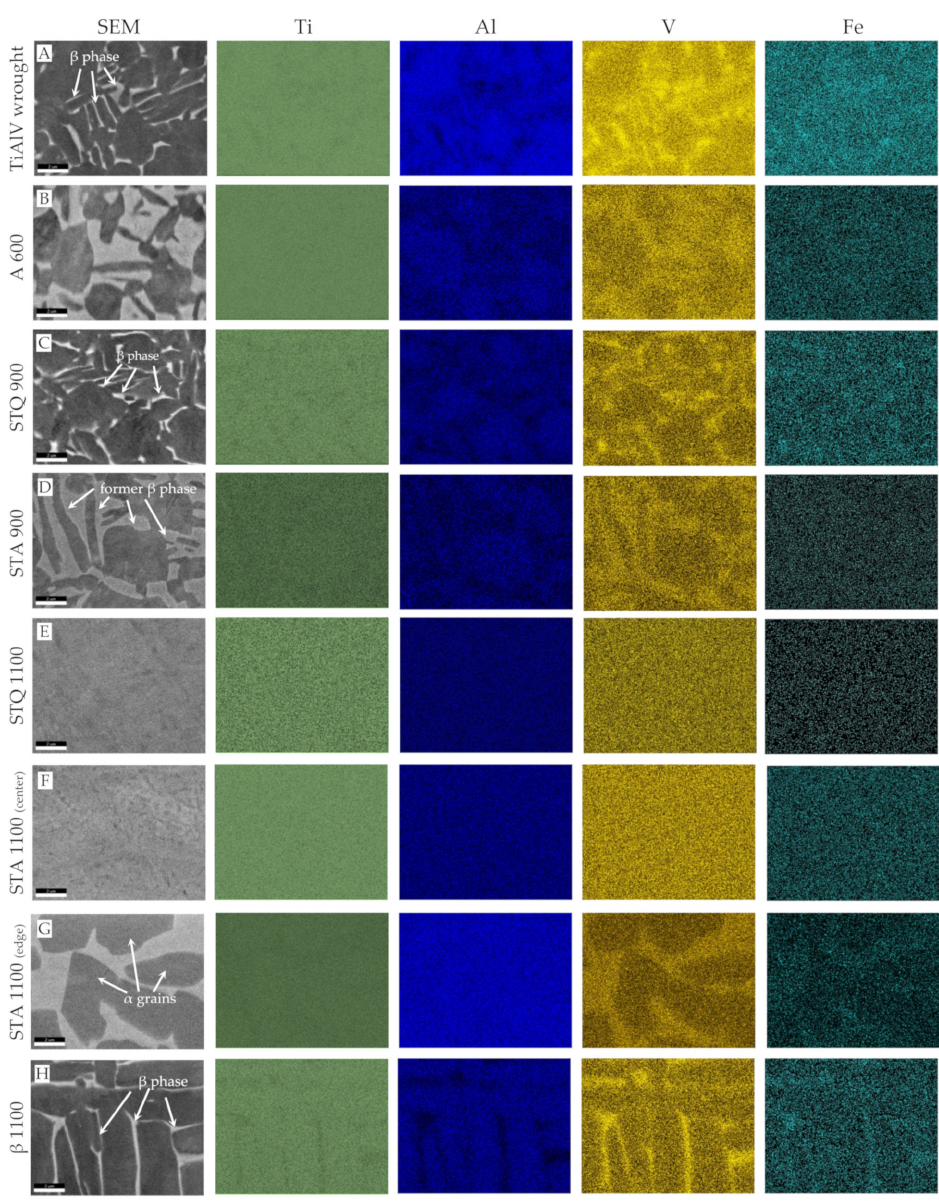
Figure 3. Electron micrographs and EDS maps showing the elemental distribution of Ti, Al, V and Fe in ( A ) the initial condition of TiAl6V4 wrought alloy and after different heat treatments, such as: ( B ) A 600, ( C ) STQ 900, ( D ) STA 900, ( E ) STQ 1100, ( F , G ) STA 1100 and ( H ) β